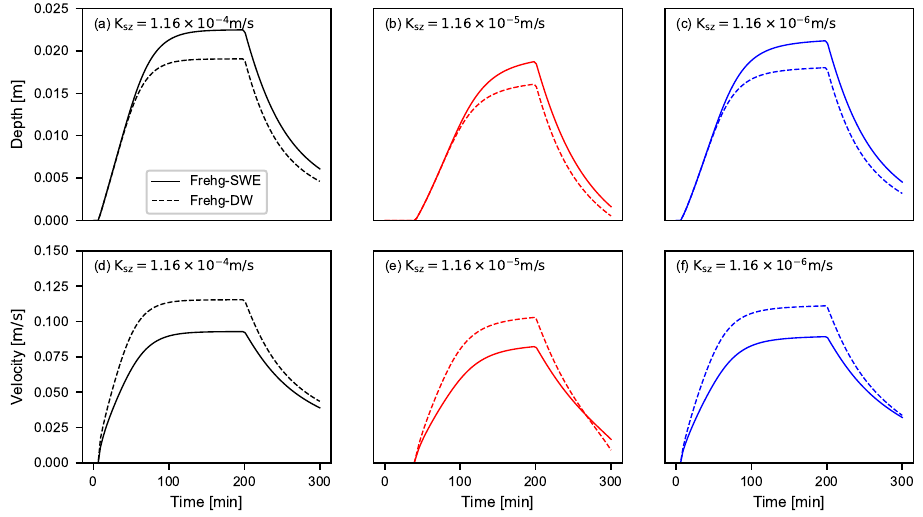
Figure 3. Runoff at ( x , z ) = ( 400,0 ) m for three test cases of rainfall on a sloping plane. The depth and velocity at the ( x , z ) = ( 400, 0 ) m are shown in Figure 4. Similar data are not reported in Sulis et al. [45], Maxwell et al. [46], but are recommended as providing insight by more recent studies [18]. For all test scenarios, the DW approxima- tion overestimates velocity while underestimating depth. A similar finding is reported in Cea and Blade [16]. Since flow depth affects inundation area, which affects surface- subsurface exchange, these results suggest the DW approximation could influence the surface-subsurface exchange in the intertidal zone that experiences wetting/drying. This idea is investigated in Sections 4.3 and 4.4.